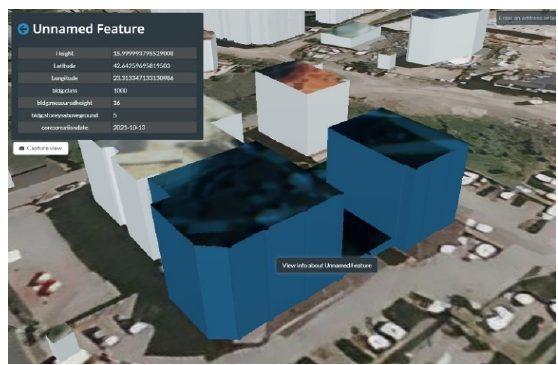
Figure 14. Building parts are selected as a single feature.